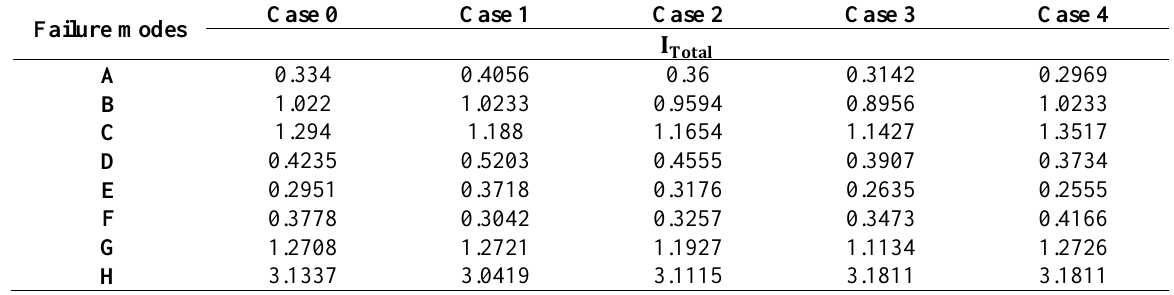
Table 10. Fuzzy FMEA analysis using FAD for all hypothetical case studies